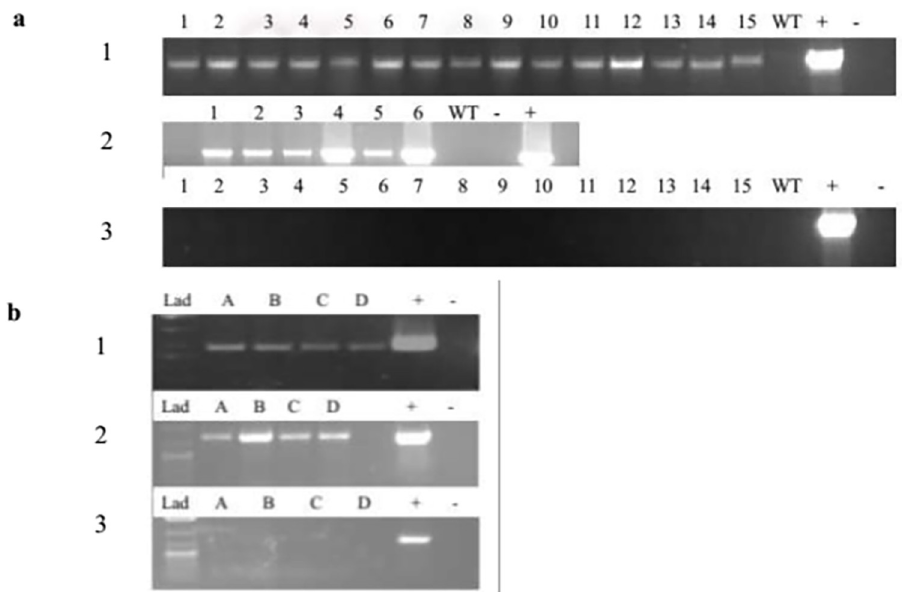
Fig 2. Detection of the transgenic tobacco by PCR analysis: a. SBP-DGAT1 transgenic plants; 1: DGAT1 (1135 bp), 2: nptII (1400 bp), and 3: vir (900 bp) are the PCR products that were synthesized by DGAT1, nptII, and vir forward and reverses primers. 1–15: putative SBP-DGAT1 transgenic plants, WT: non-transgenic plant, (+): positive control, (-): negative control. b. SBP-GUS transgenic plants; 1: SBP (574 bp), 2: nptII (700 bp), and 3: vir (700 bp) are the PCR products that were synthesized by SBP, nptII, and vir forward and reverses primers. A- D putative SBP-GUS transgenic plants, (+): positive control. (-): negative control.